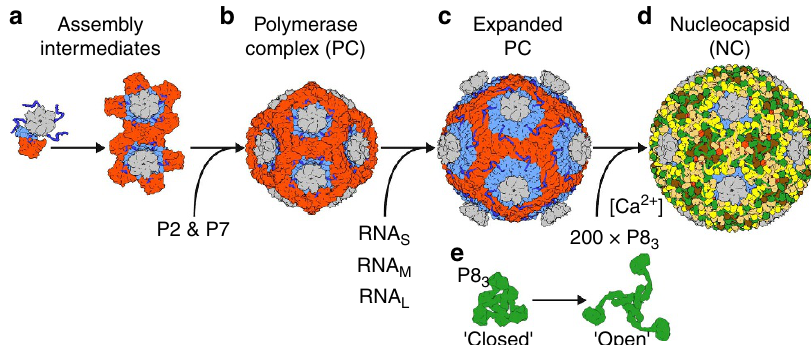
Figure 5 | Assembly model. ( a ) The f 6 inner capsid is composed of protein P1, P2, P4 and P7. Preassembled P4 hexamers (grey) nucleate the assembly of the P1 shell by bringing together two P1 subunits that will form the asymmetric P1 A –P1 B dimer (light blue and red) in the final assembly. The dimerization of P1 is facilitated by the C-terminal tail of P4 (dark blue). Up to five P1 dimers can assemble around a P4 hexamer. ( b ) P1 dimers connected to distinct P4 hexamers interact bringing together the precursors of the icosahedral vertices. This is facilitated by protein P7, which acts as an assembly cofactor. ( c ) The self-assembled empty capsids package and replicate the single-stranded RNA precursors of the f 6 dsRNA genome (S, M and L) and the capsid adopts the expanded conformation. ( d ) Trimers of P8 (green, yellow, gold and brown) then assemble around the dsRNA containing inner capsid to form the nucleocapsid. ( e ) The assembly of the P8 shell is induced by Ca 2 þ ions and involves major conformational changes in the linker regions of P8 subunits to mediate the transition from the closed to the open conformation. See also Supplementary Movie 2.